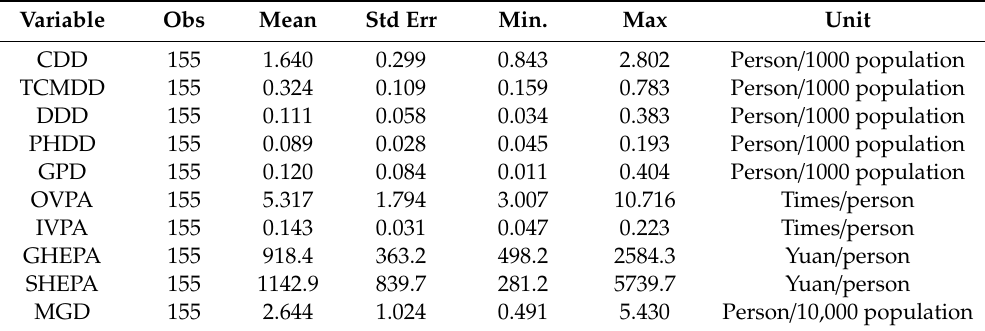
Table 3. Descriptive statistics of the variables.